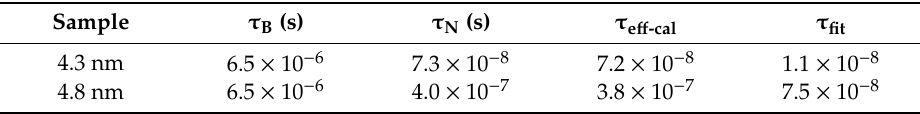
Table 3. Calculated relaxation